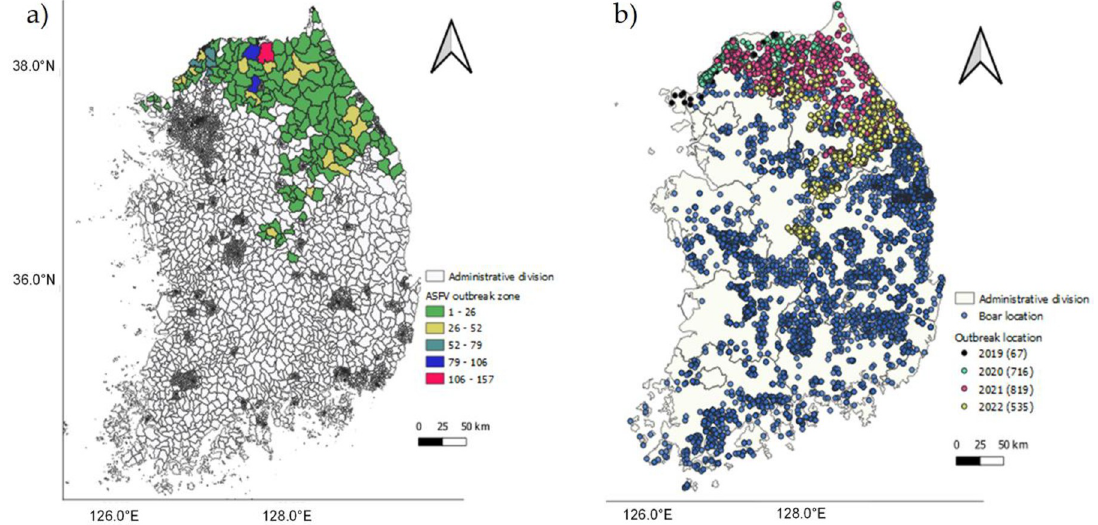
Fig 1. Survey area maps. (a) ASFV outbreak frequency in local administrative areas, and (b) ASFV outbreak and reported locations of wild boar in provincial administrative areas analyzed using QGIS version 3.24.1. Authors specify that this figure is licensed under CC BY 4.0.